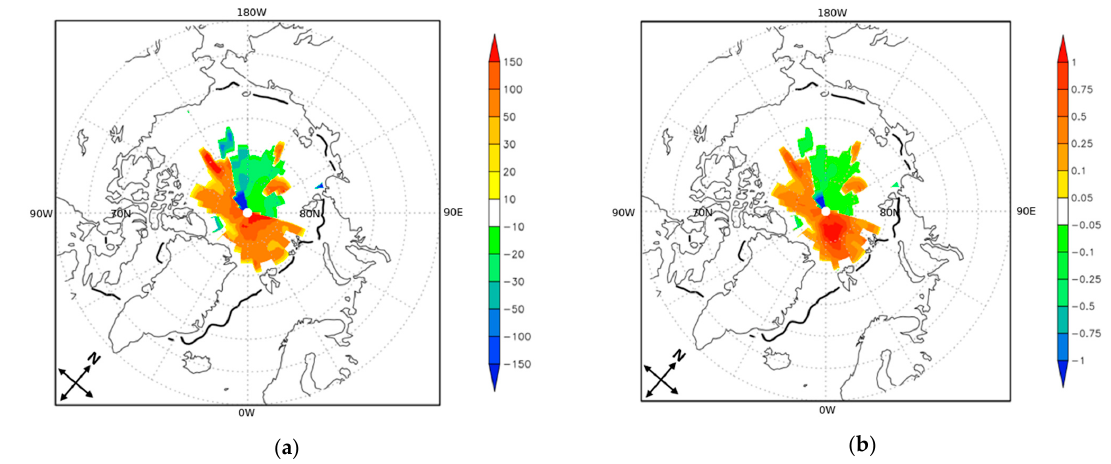
Figure 17. Anomaly of BC concentration in snow in August for one realization, ng/g ( a ) and a similar anomaly for radiation forcing from BC in snow, W/m 2 ( b ).